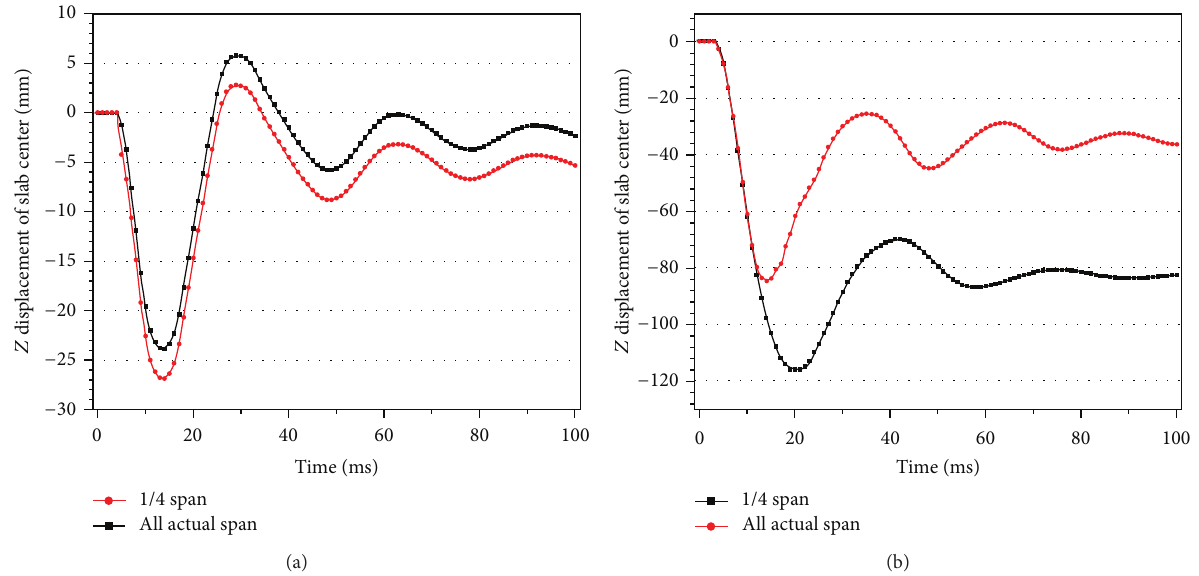
Figure 15: Displacement time histories of RC slab center under different reinforcement types: (a) 𝑊 = 30 kg and (b) 𝑊 = 75 kg.